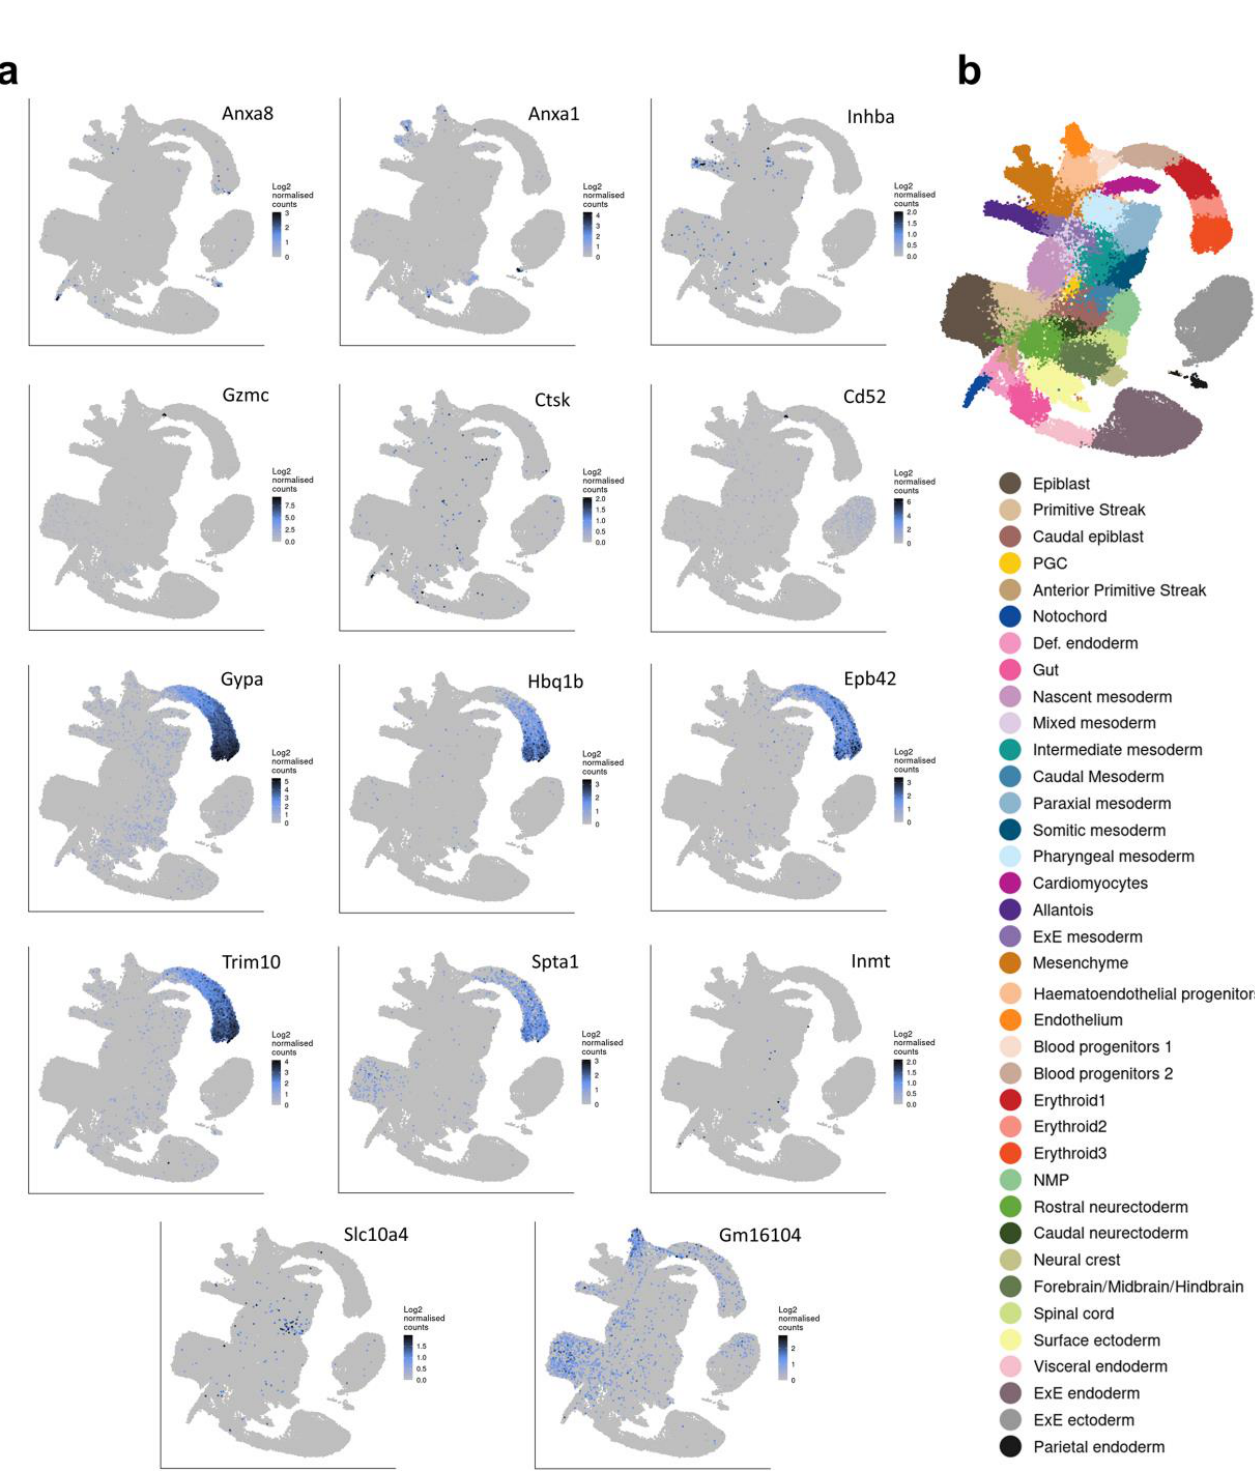
Figure 4. Tissue distribution of 14 genes significantly upregulated in Commd10 Null embryos on E8.5. ( a ) Single-cell molecular maps of mRNA expression in WT embryos for the top 14 genes significantly upregulated in Commd10 Null embryos on E8.5. ( b ) Legend for (a) annotating cell clusters by different colors, and a single-cell molecular map of mouse gastrulation and early organogenesis [22] up to day E8.5 of embryogenesis. All presented plots were generated on a single-cell molecular map of mouse gastrulation and early organogenesis. at https://marionilab.cruk.cam.ac.uk/MouseGastrulation2018/ (accessed on 2 September 2022) website.